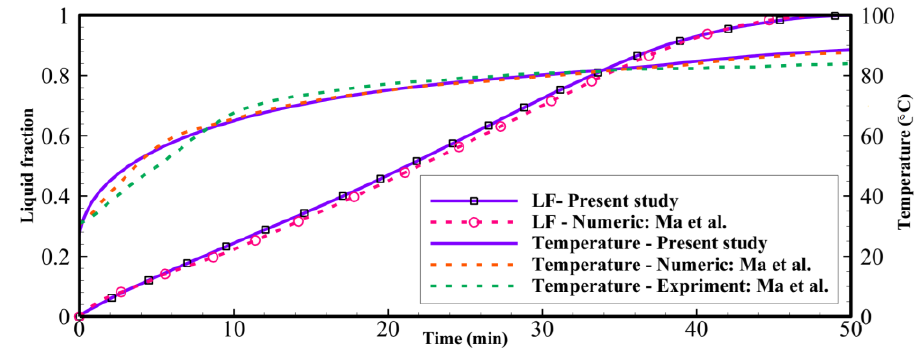
Figure 3. Comparison of the present study with the experimental data of Mat et al. [36].